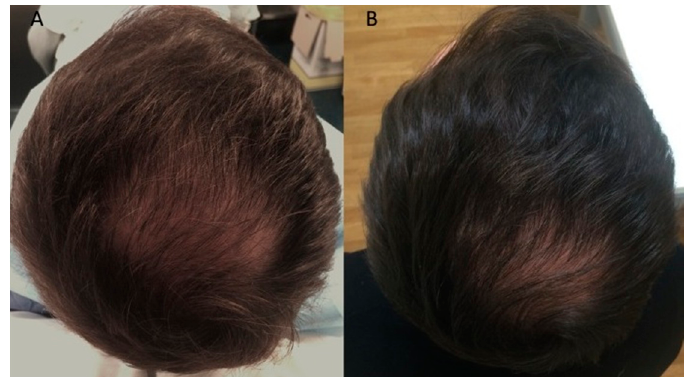
Figure 2. Clinical case of a male patient affected by androgenetic alopecia. ( A ) Pre-operative situation of the frontal, temporal, parietal, and vertex area; ( B ) Post-operative situation after three A-PRP injections with increase in the hair count and hair density.